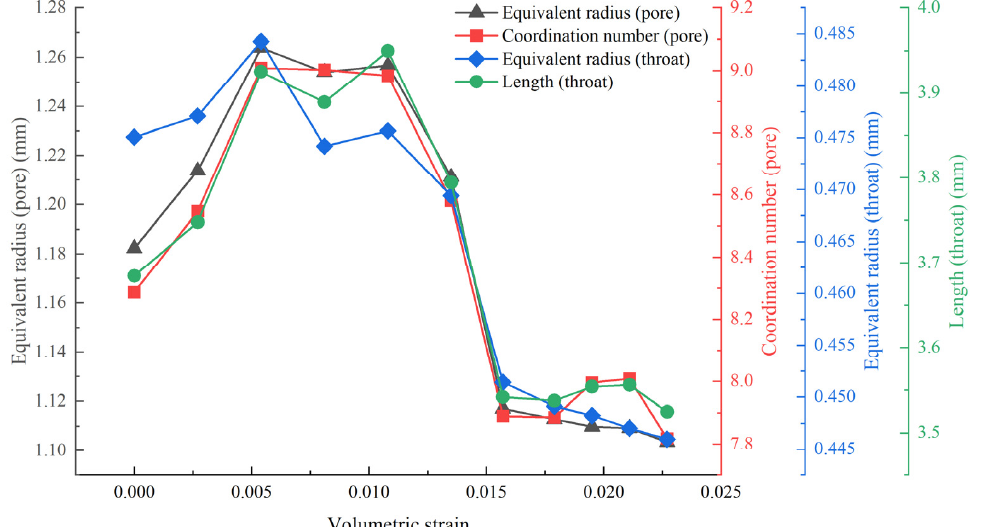
Figure 7. The porosity decreases as the stress increases in the same porous medium. In order to quantitatively characterize the 3D pore structure under triaxial pressure, a topologically equivalent 3D pore network model was established based on the simula- tion results of different particle sizes. In order to characterize the pore structure and study the influence of stress on the pore − throat parameters, the total pore volume, average pore equivalent radius, average throat equivalent radius, average pore–throat ratio and aver- age coordination number were measured and recorded. The variation curve of the pore throat parameters with stress is shown in Figure 8.